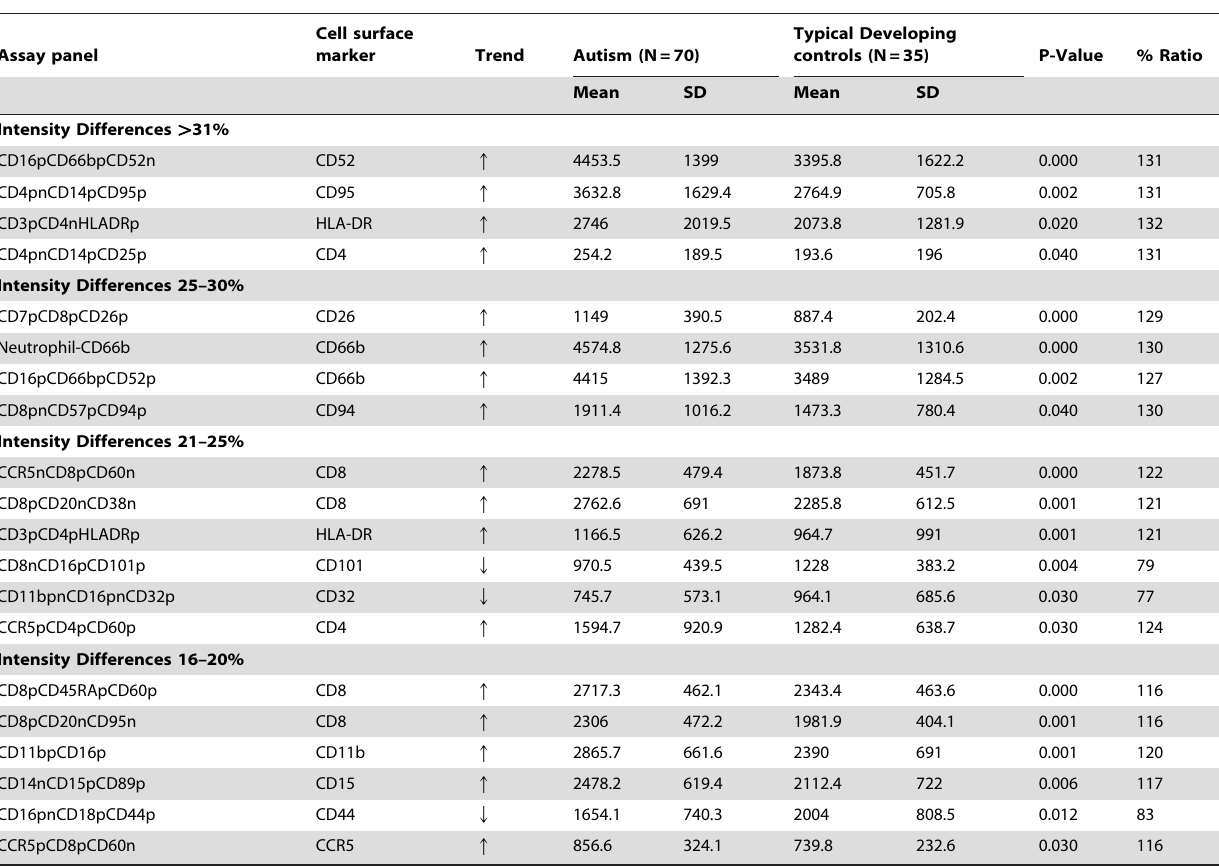
Table 7. The 20 most different cell surface markers based on fluorescent intensities.